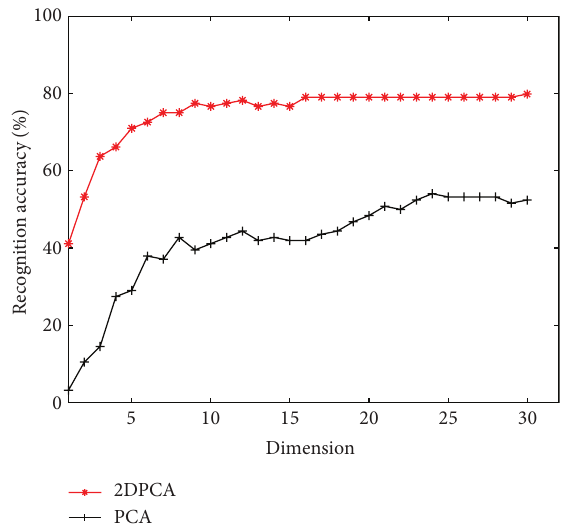
Figure 7: The rank 1 recognition accuracy comparison of 2DPCA and